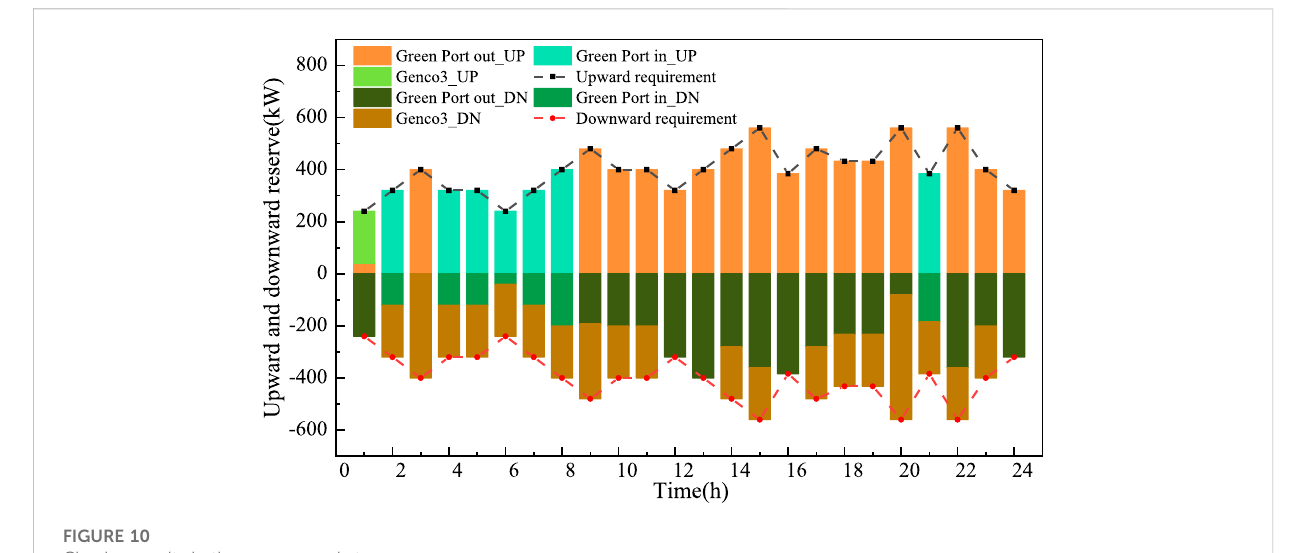
FIGURE 10 Clearing results in the reserve market.